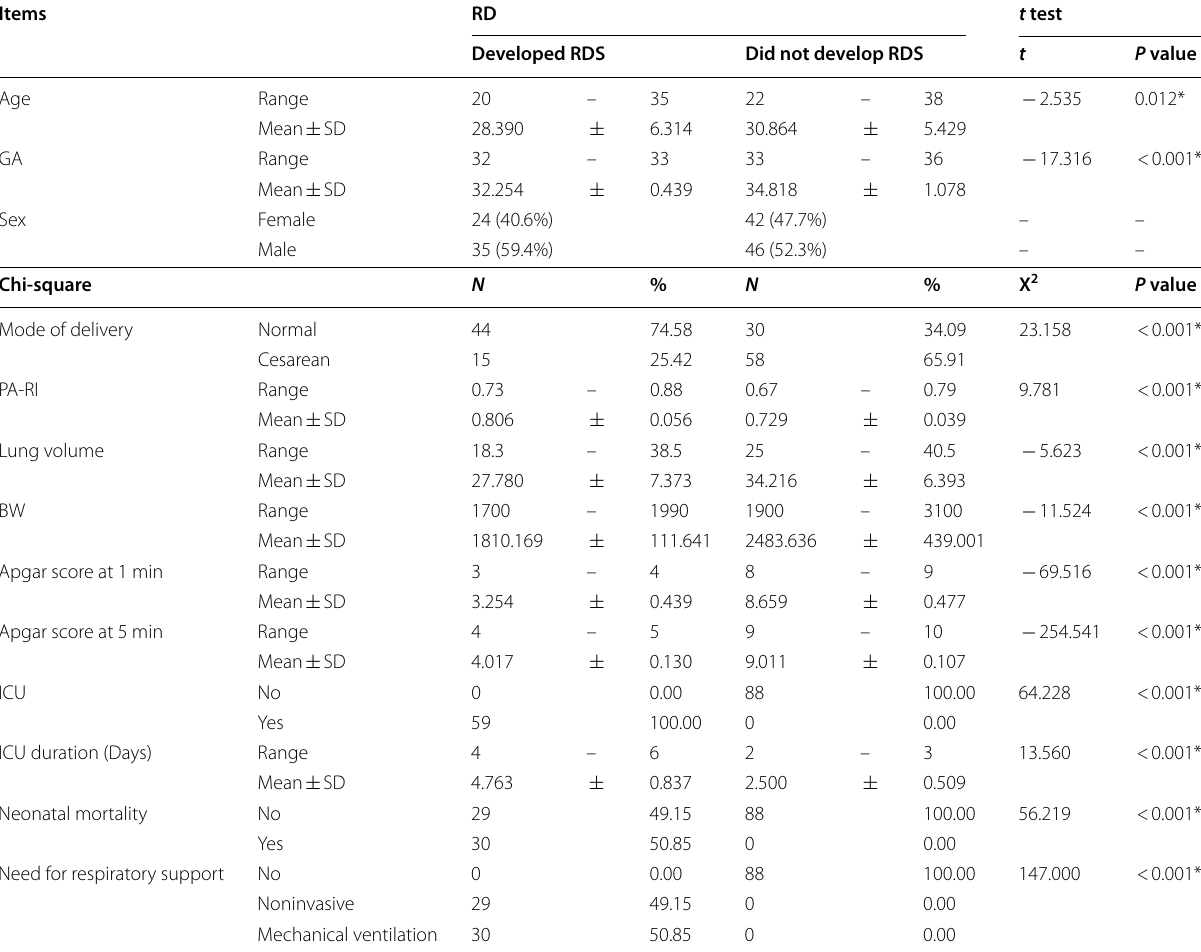
Table 3 Comparison between fetuses with and without neonatal respiratory distress